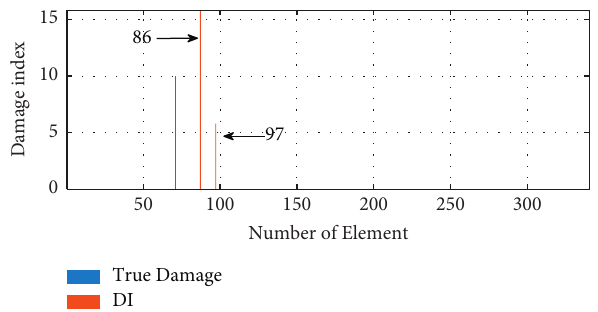
Figure 22: Results of damage scenario D1 using incomplete mode